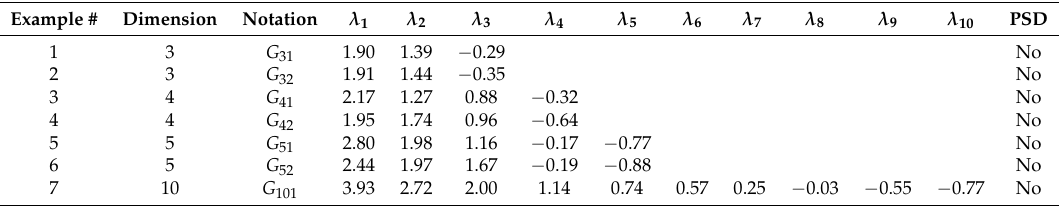
Table 2. Eigenvalues in our examples, before PSDization